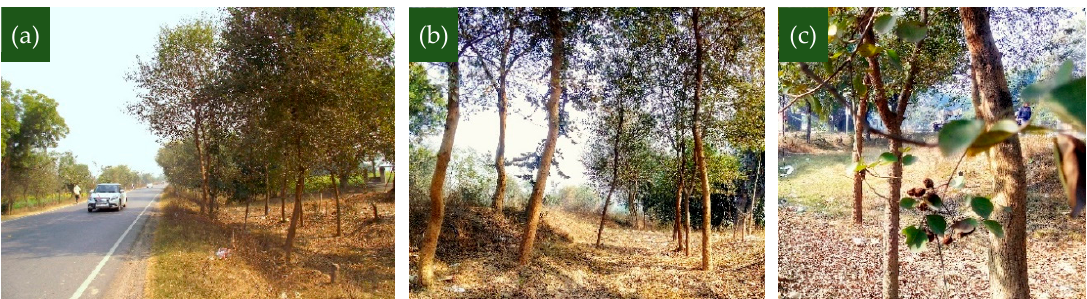
Figure 1. Dalbergia sissoo can grow in diverse edaphic conditions as it has habitat plasticity and adaptive capacity: ( a ) D. sissoo growing along roadsides, ( b ) marginal land, ( c ) and improving soil fertility through litter turn-over and N-fixation.